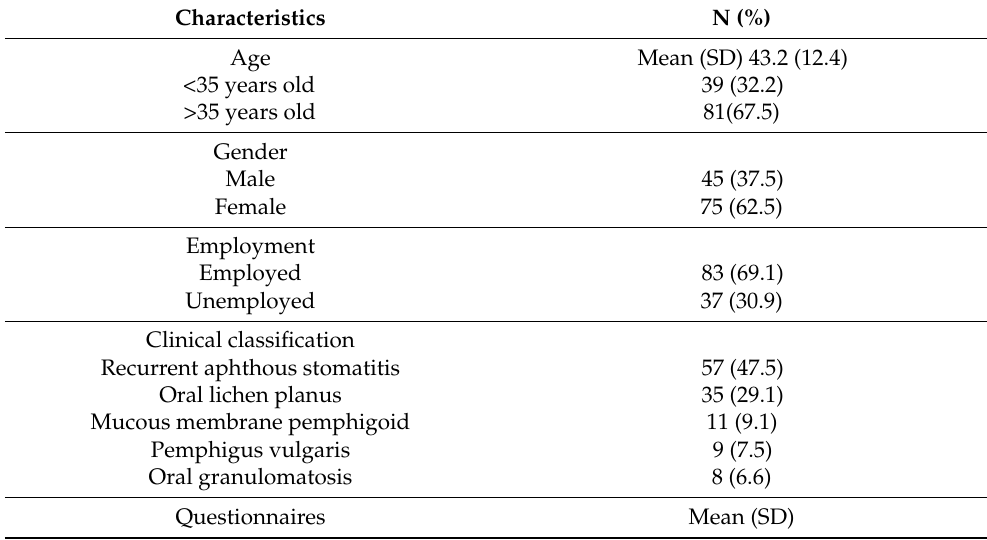
Table 1. Characteristics of patients and descriptive statistics of COMDQ, OHIP-14, and